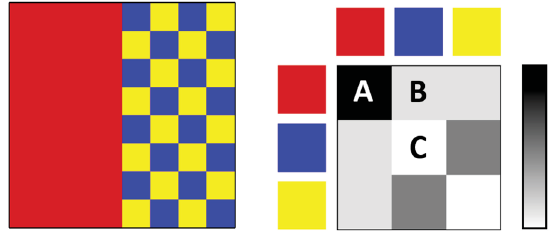
Fig. 3 Left: an image. Right: corresponding co-occurrence matrix, computed by Eqs. (1) and (2), using 4-neighborhood connectivity. Red pixels are frequently adjacent: their co-occurrence measure is high (A). Red pixels appear less frequently next to blue ones, giving a lower value in the co-occurrence matrix (B). Blue pixels are never adjacent, yielding a zero probability